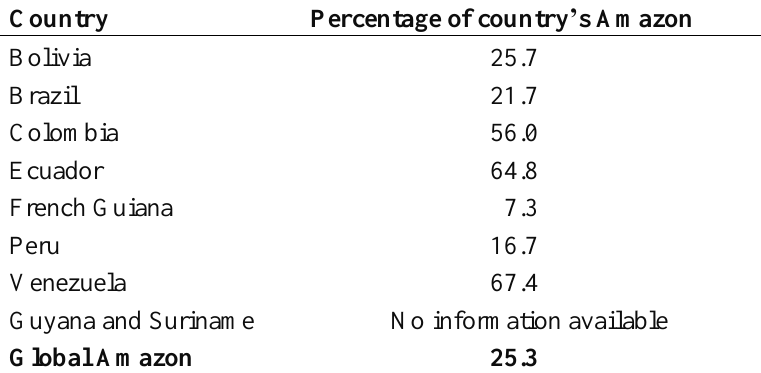
Table 1. Indigenous territories in the Global Amazon